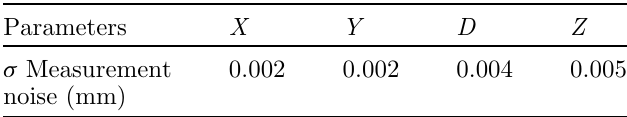
Table 5. Estimation of the measurement dispersion of the control means.